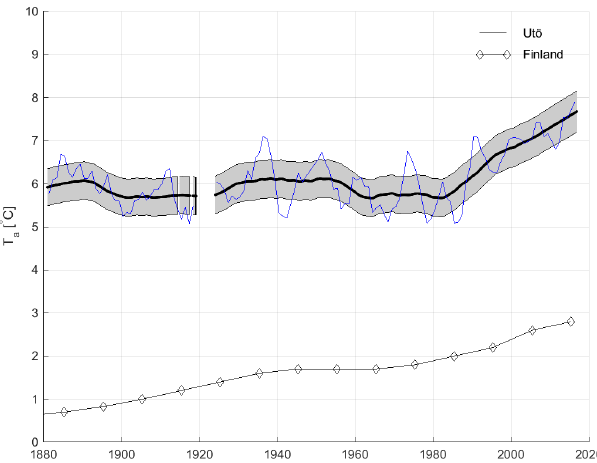
Figure 2. Average annual air temperatures at Utö during 1881– 2016. The solid line represents temperatures calculated with DLM, and the gray area shows the 95% confidence range calculated using bootstrap method. The blue line over the DLM curve is a 5-year run- ning mean of atmospheric temperature at Utö. The thin black line with diamonds shows the decadal average temperatures calculated for all of Finland (Mikkonen et al.,